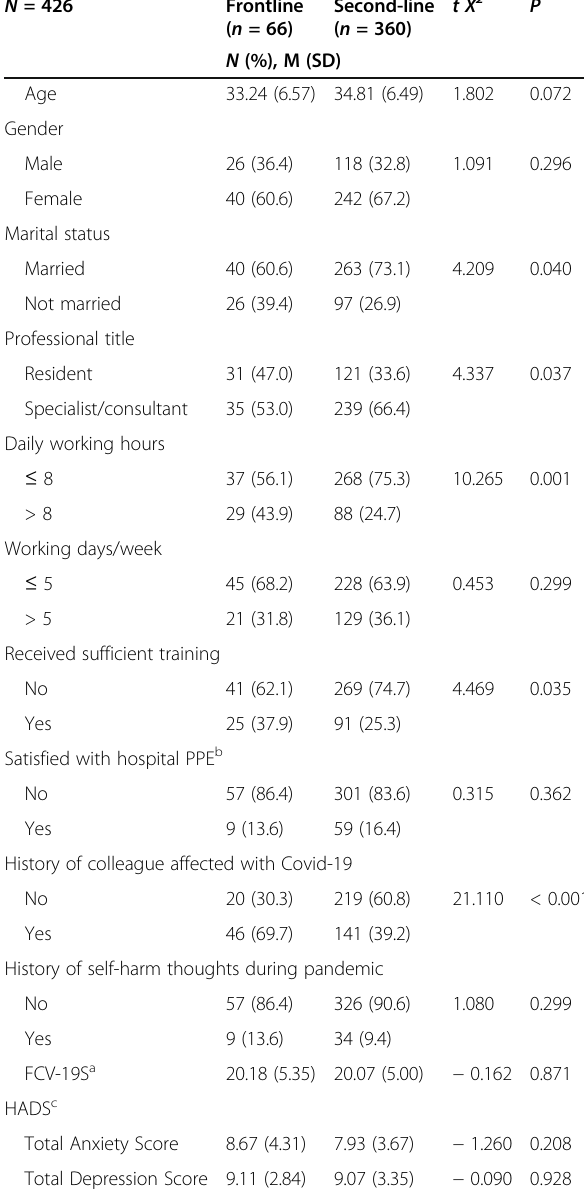
Table 3 Comparison between frontline and second-line physicians regarding their demographic and clinical